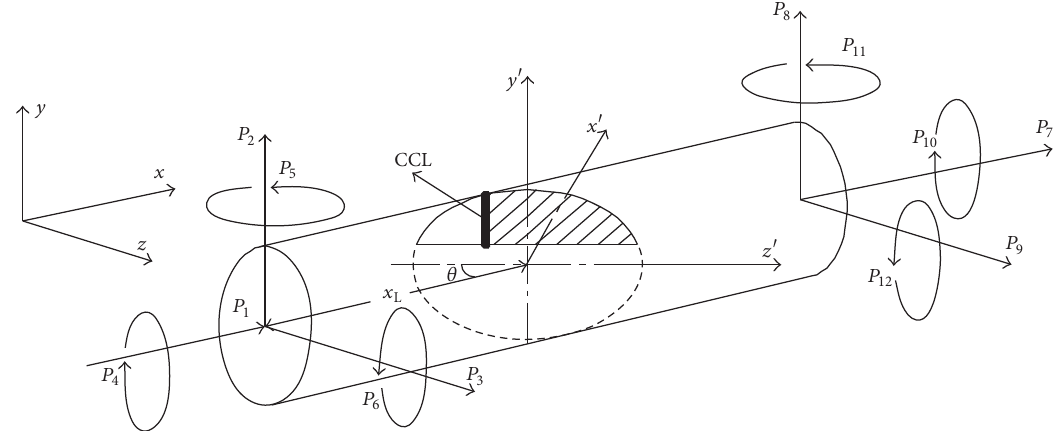
Figure 1: Schematic diagram of cracked shaft